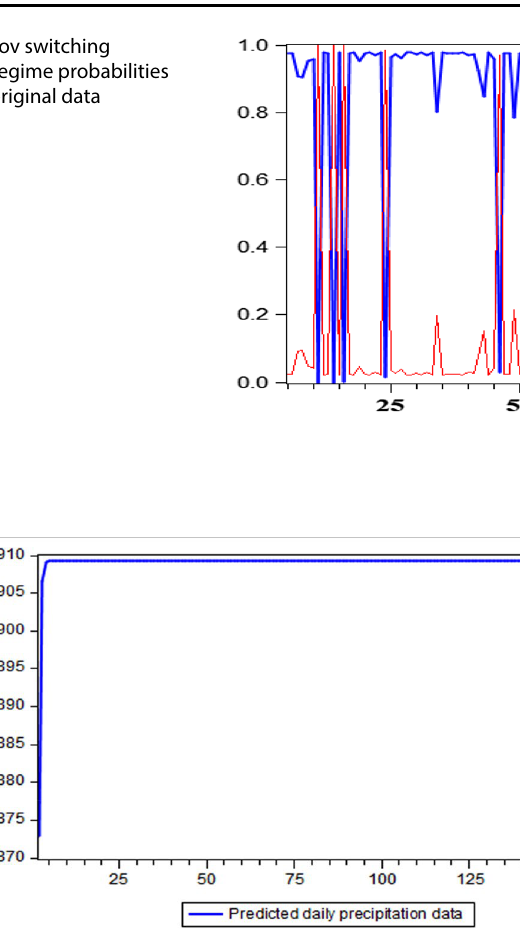
Fig. 3 The daily rainfall probabilities based on the original data in Iran